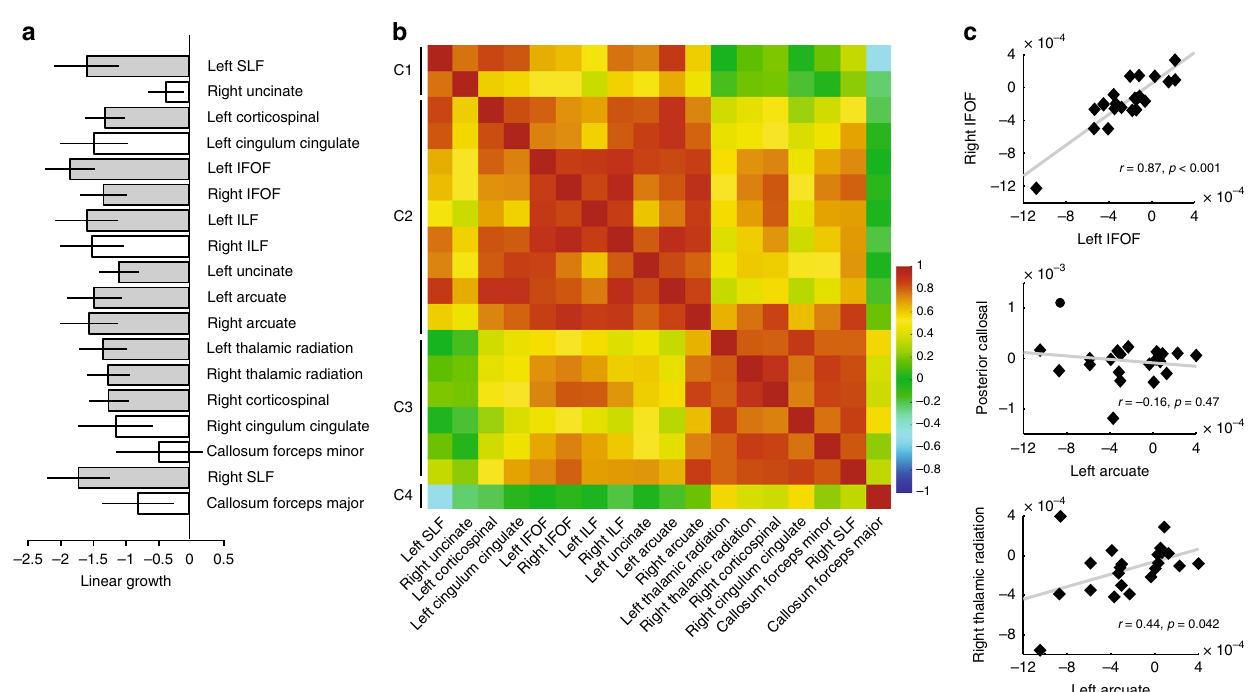
Fig. 6 Reading intervention causes distributed changes in the white matter. a Change in MD as a function of intervention time (in hours) for 18 tracts. Tracts showing signi fi cant change (Bonferroni-corrected p < 0.05) are indicated as gray fi lled bars. Error bars depict standard errors from a linear mixed effects model. b Hierarchical clustering based on the correlations between linear growth rates. The heat map represents Pearson correlations between linear growth rates for pairs of tracts across individuals. The matrix is sorted according to hierarchical clustering of these correlation coef fi cients. c Scatter plots of individual growth rates for three pairs of tracts: left vs. right IFOF, AF vs. CC, and AF vs. right thalamic